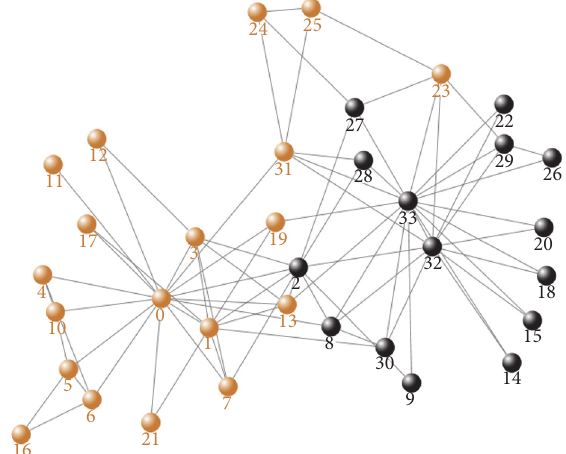
Figure 9: The result of Clauset algorithm on